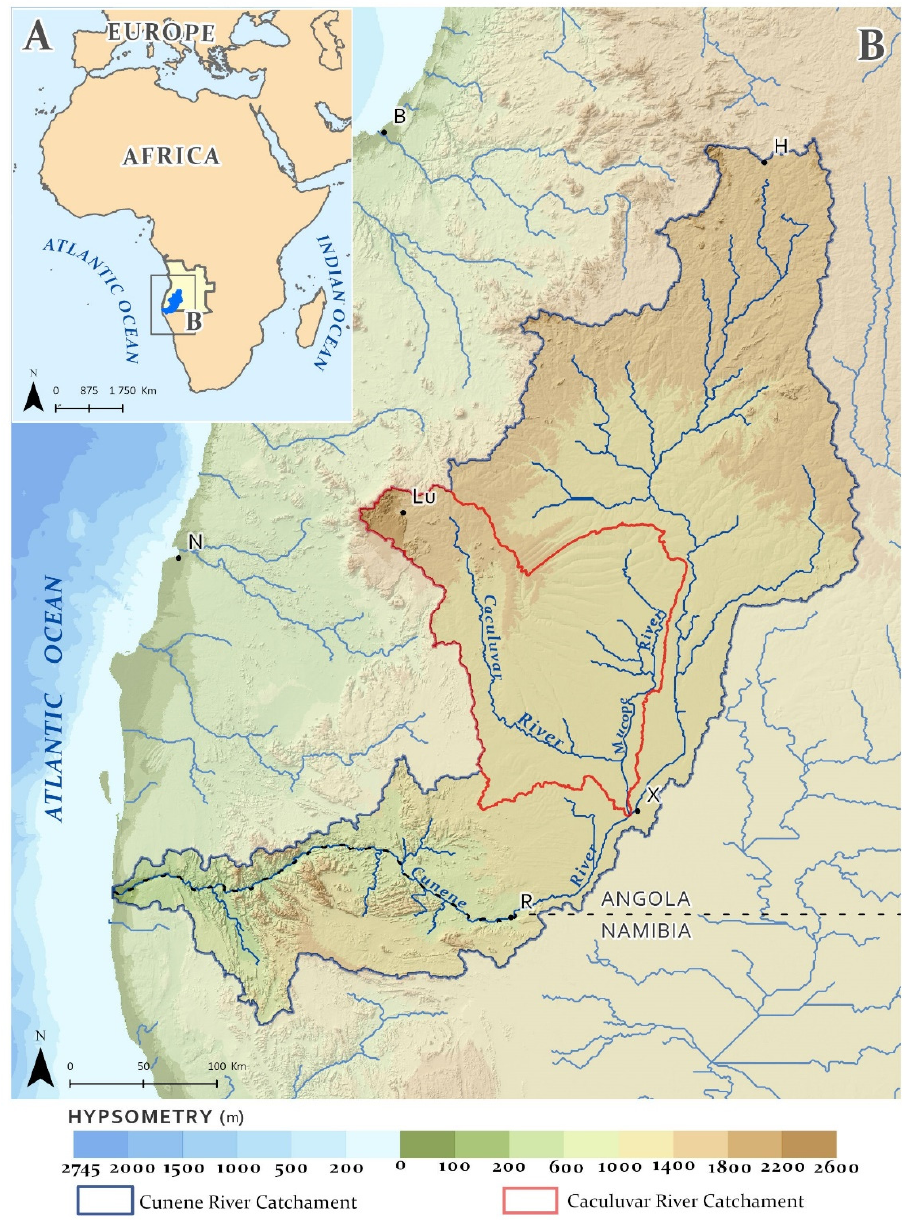
Figure 1. Location of the Cunene ( A ) and Caculuvar ( B ) basins in the SW of Africa.